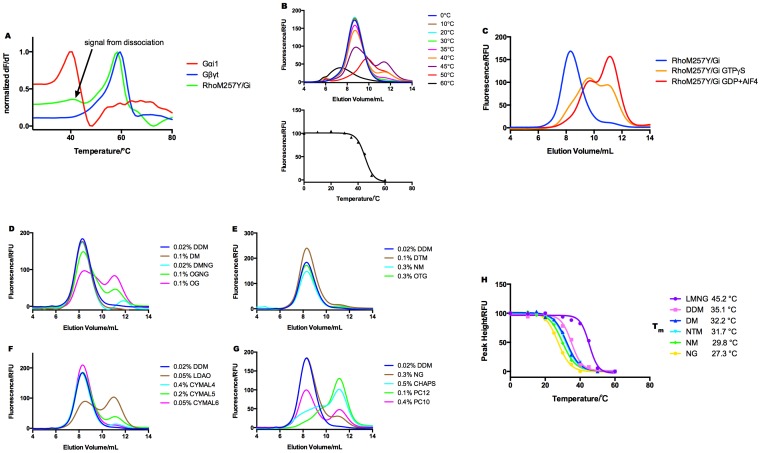
RhoM257Y/Gi is active and shows higher stability than RhoM257Y/Gt.
A: fluorescent dye (CPM) assisted thermal denaturation assay and B: FSEC-TS assay. C: The Gi in RhoM257Y/Gi complex adopts active conformation showing dissociation upon incubating with GTPgS or GDP and AlF4. D,E,F,G: RhoM257Y/Gi complex is resistant to wide variety of detergents. H: Thermostability analysis of RhoM257Y/Gi by FSEC-TS in selected detergents.